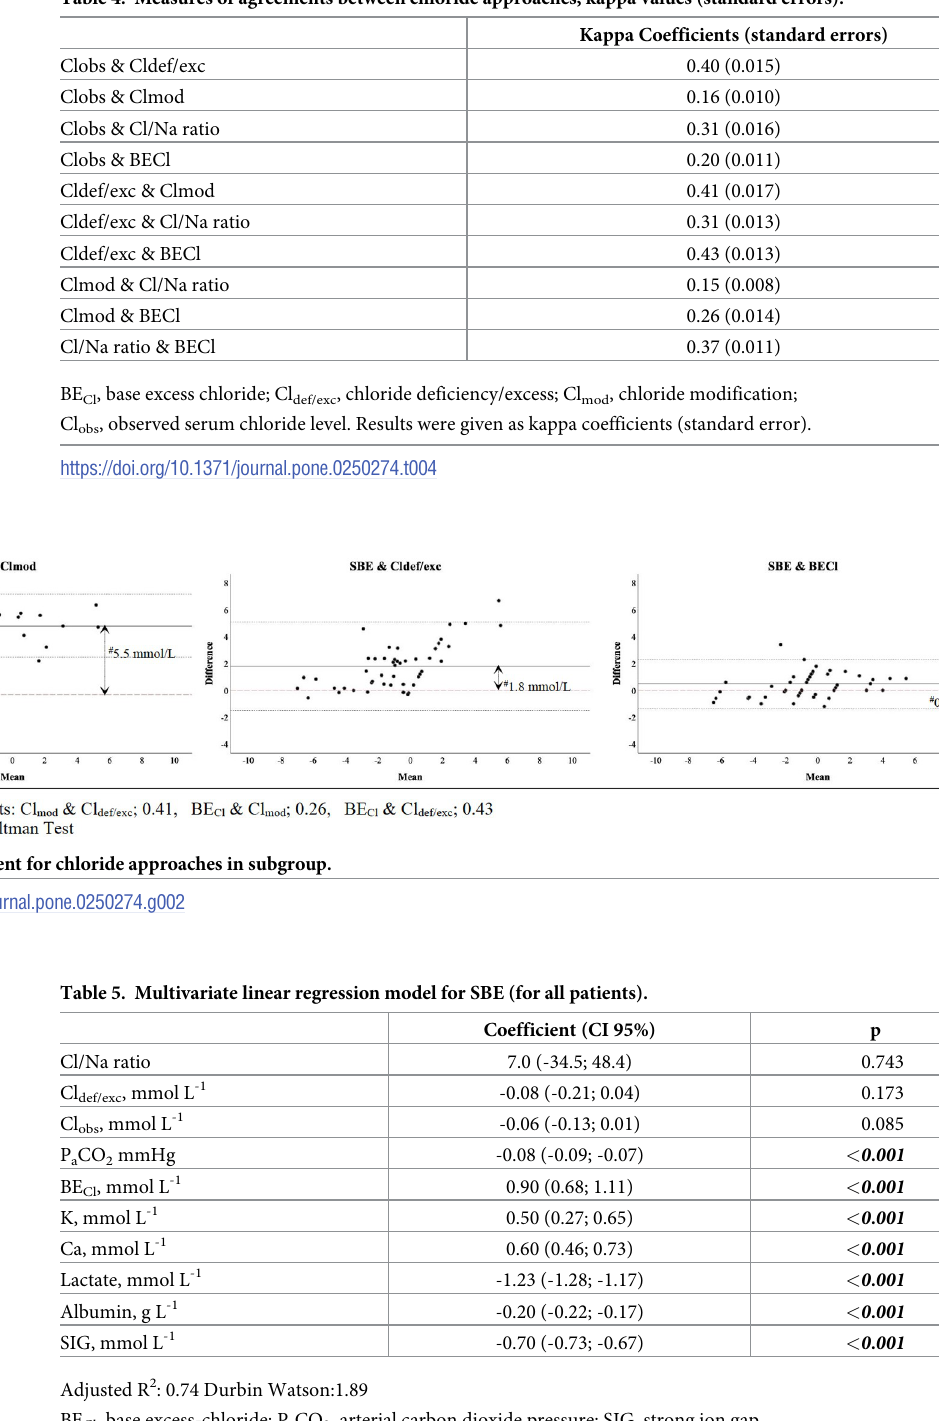
Table 4. Measures of agreements between chloride approaches, kappa values (standard errors).